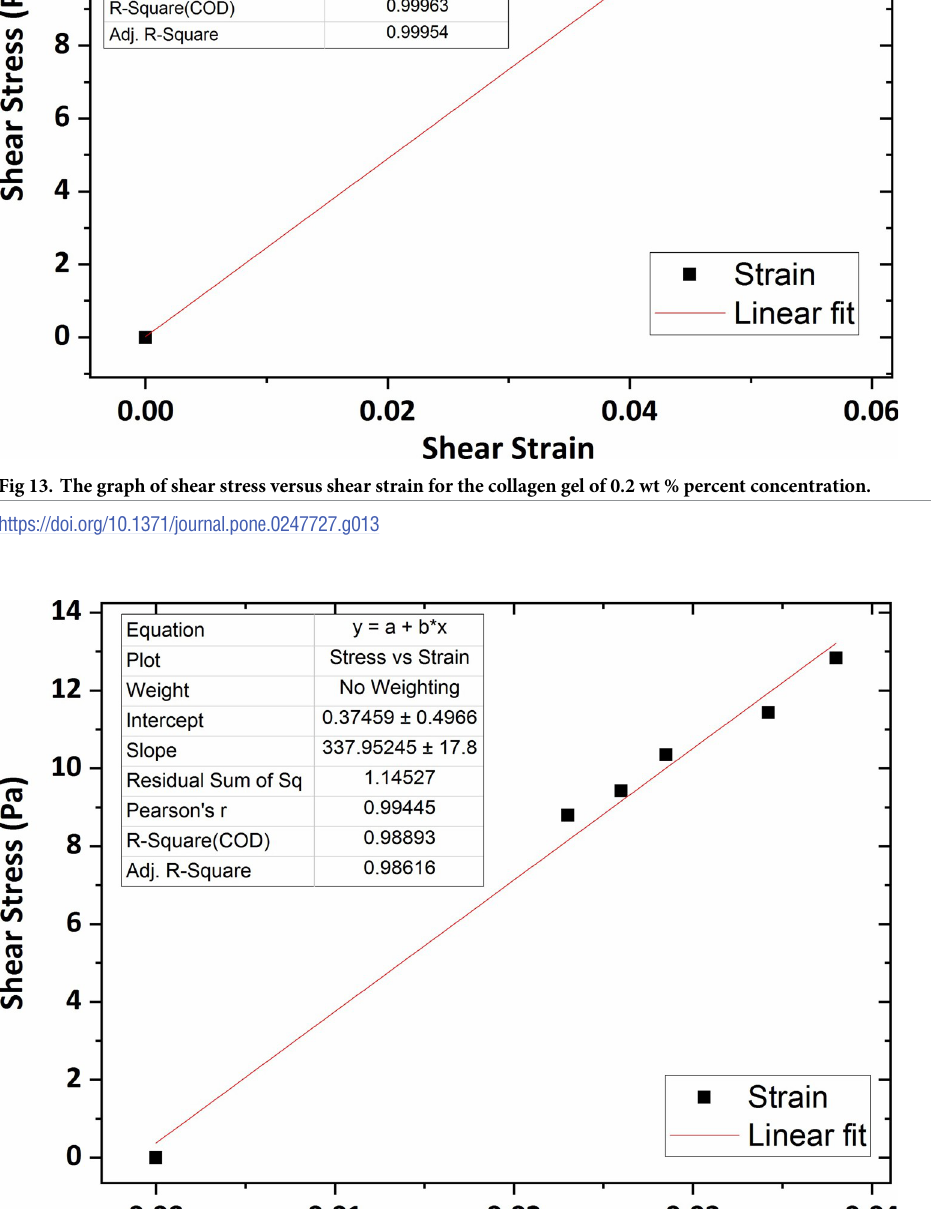
PLOS ONE | https://doi.org/10.1371/journal.pone.0247727 February 25, 2021 17 /